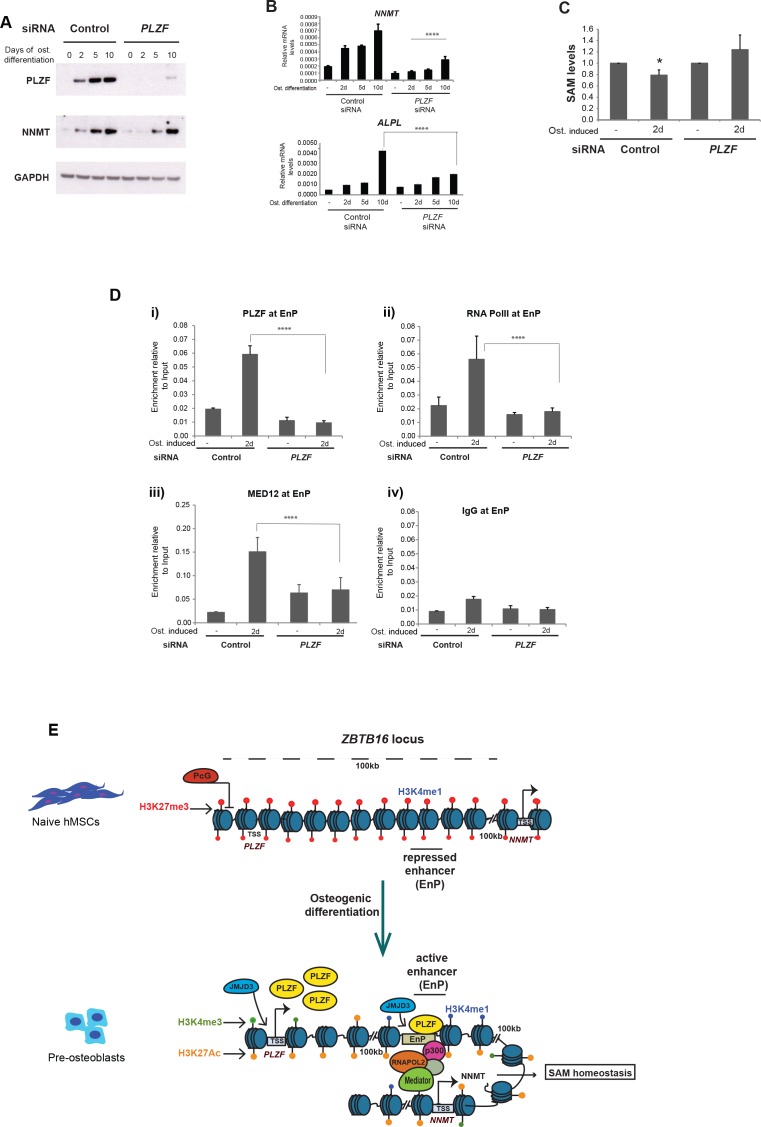
PLZF is required for MED12 and RNA PolII recruitment at the EnP enhancer.A) Knockdown of PLZF by siRNA prevents efficient induction of the NNMT gene. hMSCs were transfected with siPLZF or control siRNA, left untreated or added osteogenic differentiation medium in a time course experiment. (A) Western blot showing the knockdown efficiency of PLZF and the influence on NNMT expression during osteogenic differentiation (western blot in A, representative blot from two biological replicates and RT-QPCR in B, the data shown are mean ± SD from three biological replicates, ****p < 0.0001). The impact of PLZF knockdown on ALPL expression is shown in the lower part of the panel B. The data shown are mean ± SD from three biological replicates, ****p < 0.0001, significance was calculated by two-way ANOVA using Tukey’s multiple comparisons test. (C) Fluorescence based SAM assay revealed that PLZF knockdown prevented the decline in SAM levels as observed in control siRNA cells (tested as significant p = 0.01 two tailed t-test) during early osteogenic differentiation (day2). The data shown here is an average of three biological replicates. (D) ChIP followed by QPCR for PLZF, RNA PolII, and MED12 at the EnP element before and after PLZF knockdown in hMSCs. Osteogenic differentiation was induced one day after siRNA transfection and cells were fixed for ChIP two days later. The data represents two biological replicates and show averages of triplicate values from QPCR ± SD. ****p < 0.0001, significance was calculated by two-way ANOVA using Tukey’s multiple comparisons test. (E) Model to show that the ZBTB16 locus is repressed by Polycomb protein complexes (PcG) and marked by H3K27me3 in naive hMSCs. Upon induction of osteogenic differentiation, the ZBTB16 locus gets derepressed by losing PcG binding, and H3K27me3 through JMJD3 recruitment, gain H3K27ac which eventually results in high expression of PLZF. The intragenic enhancer ‘EnP’ gets exposed, gains H3K27ac and H3K4me1 histone marks and binds PLZF as well as P300 and the Mediator complex. Subsequently, the EnP element loops to the promoter of the NNMT gene (100 kb downstream) and induce its expression and as a consequence regulates SAM homeostasis during osteogenic differentiation of hMSCs.Figure 7—source data 1.ChIP for enhancer binding proteins in hMSCs, in the absence of PLZF.